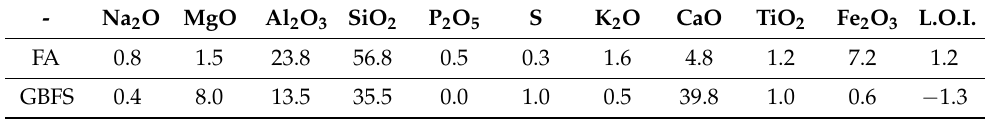
Table 1. Chemical compositions of FA and GBFS measured with XRF (%).